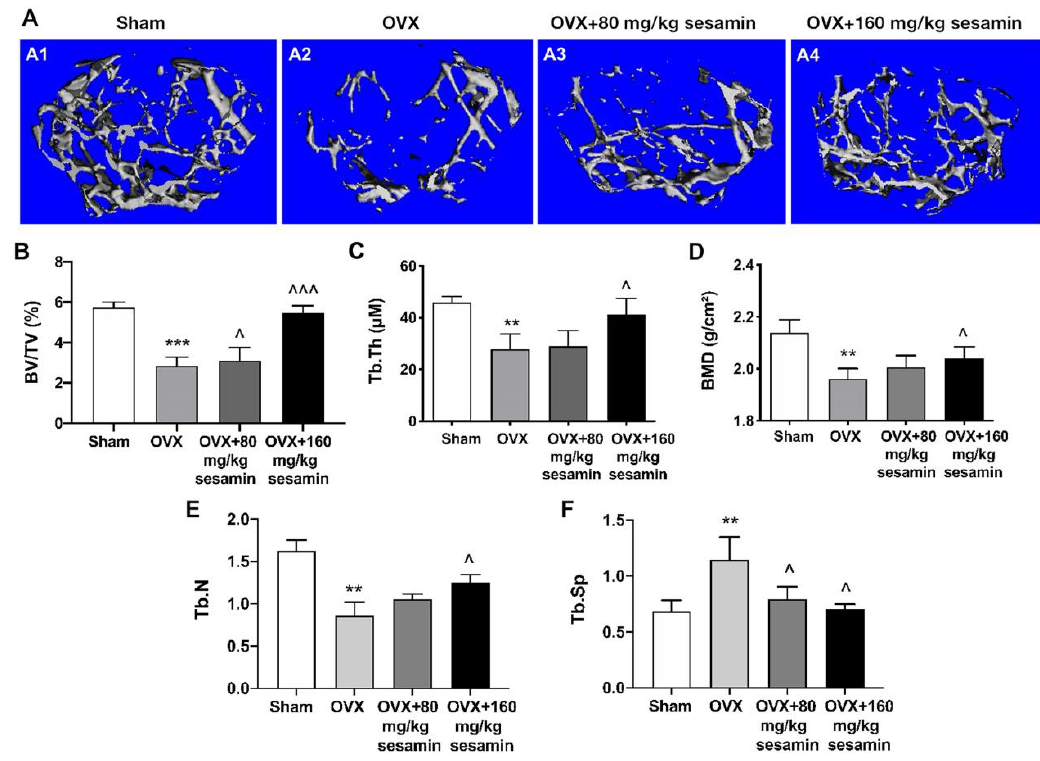
Figure 6. Microstructure properties of the trabecular bone of OVX mice after sesamin treatment. ( A ) Three-dimensional reconstruction of trabecular bone in the distal metaphysis of OVX mice after sesamin treatment. Scale bar, 100 μM. ( B – F ) Microstructure parameters including bone volume/tissue volume (BV/TV) ( B ), trabecular thickness (Tb.Th) ( C ), bone mineral density (BMD) ( D ), trabecular number (Tb.N) ( D ) and trabecular space (Tb.Sp) ( E ) of the trabecular bone. Data were shown as mean ± SD ( n = 8; ** p < 0.01, *** p < 0.001, versus sham group; ^ p < 0.05, ^^^ p < 0.001. versus OVX group).